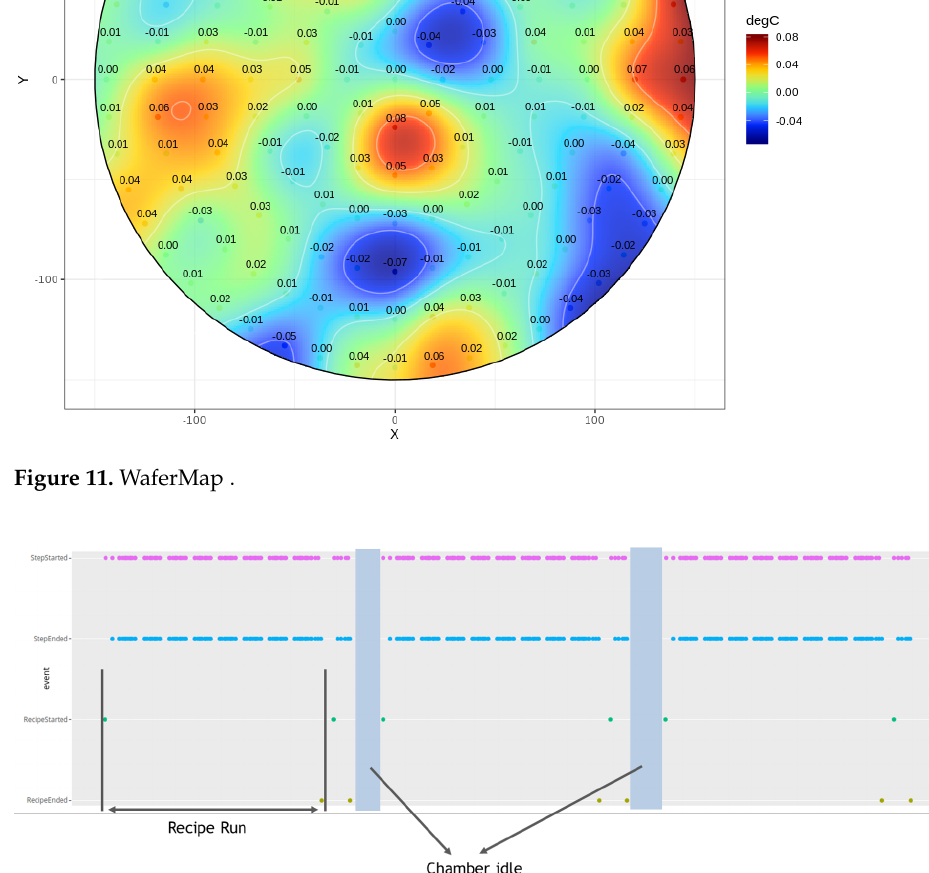
Figure 12. Check the Idle